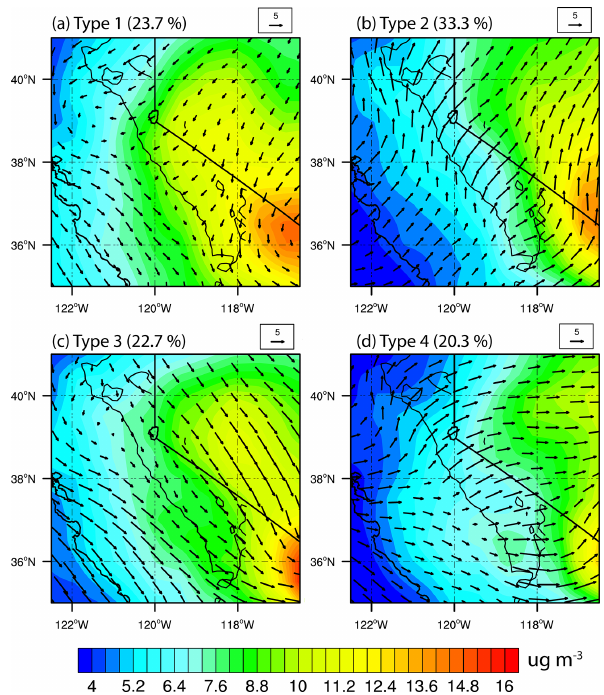
Figure 11. Low-level dust concentration (ugm − 3 ) and wind vec- tors (ms − 1 ) in each of the four SOM types from MERRA-2 for the year 2019. The numbers above the panels denote the frequency of each type.